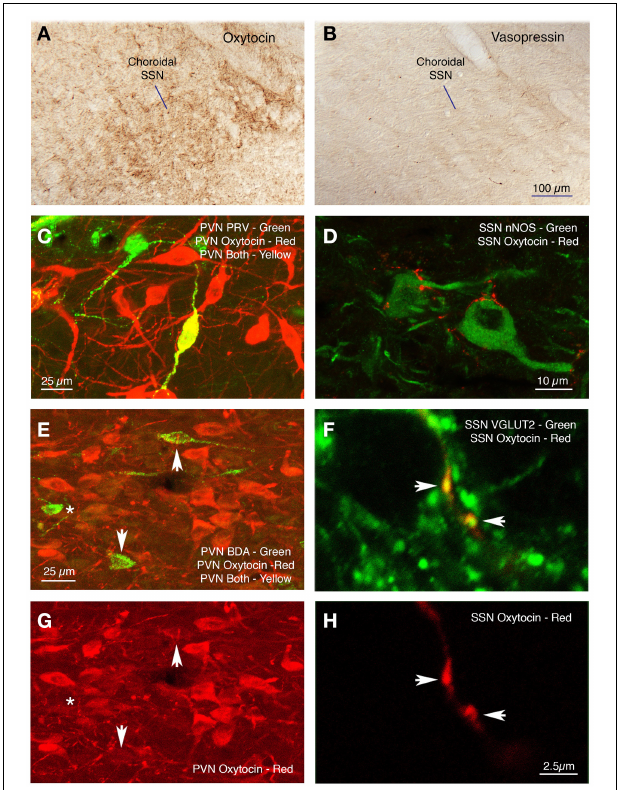
FIGURE 8 | Oxytocinergic terminals are abundant in prechoroidal SSN (A), but vasopressinergic terminals are rare (B). Immunofluorescence double labeling shows a PRV + neuron (green) in dorsal parvicellular PVN that contains oxytocin (red) and thus appears yellow in the image (C) , and oxytocin-containing terminals ending on nNOS+ choroidal neurons of SSN (D) . (E,G) Show immunofluorescence double labeling for BDA (green) and oxytocin (red) in PVN, showing that two of the BDA + cells are lightly labeled for oxytocin (arrows) and one is not (asterisk). (F,H) Show immunofluorescence double labeling for oxytocin (red) and VGLUT2 (green) in choroidal SSN. Note that both oxytocinergic terminals in SSN (arrows) are also positive for VGLUT2, as shown in the merged image for both (F) .